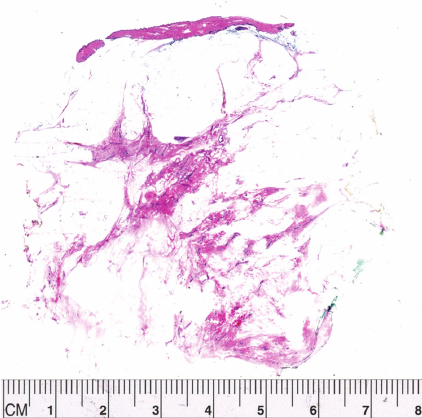
Figure 5: In this case, the patient had pathologic complete response (pCR). The entire specimen was examined microscopically. Slices one and three were cut in the perpendicular plane and slice 2 submitted for large format. A 100% of this 7.5 cm lumpectomy was examined microscopically with 12 standard sections and one large section.